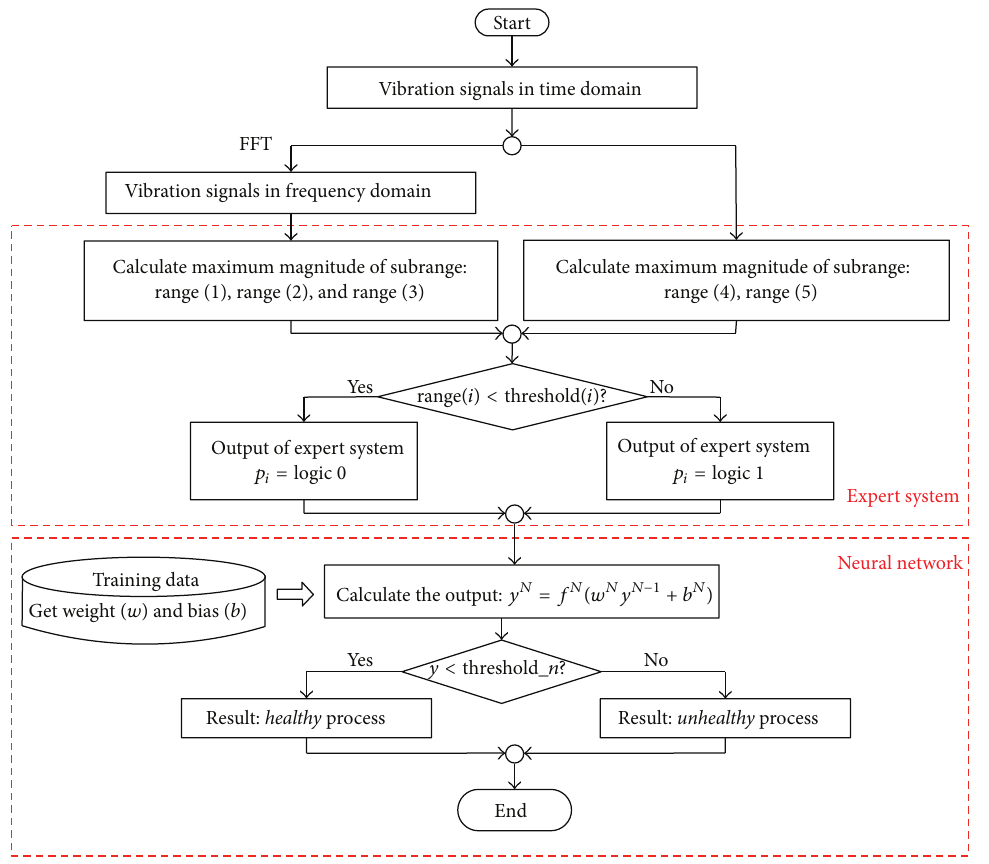
Figure 15: Flowchart of neural-expert